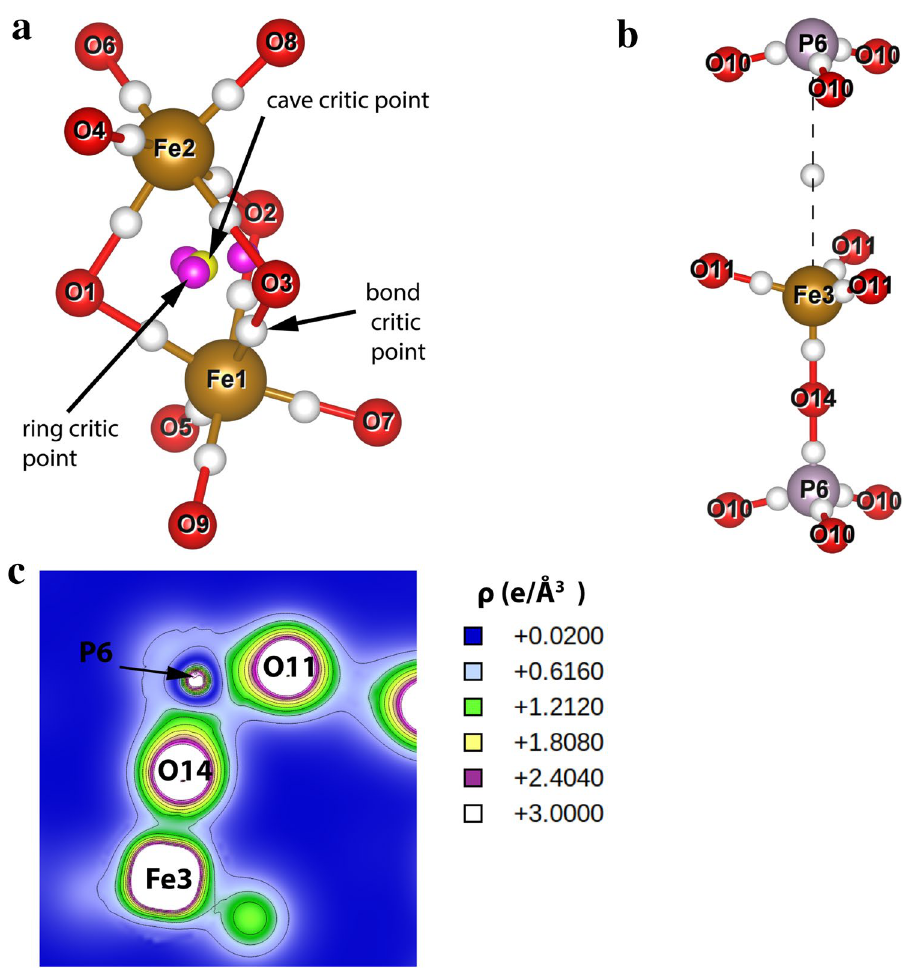
Figure 7. Critic points for (a) [Fe1O 6 ]–[Fe2O 6 ], (b) for [Fe3O 4 ]–[PO 4 ] and (c) valence electrons density map showing the connection Fe3–O14–P6 for Fe 7 P 11 O 38